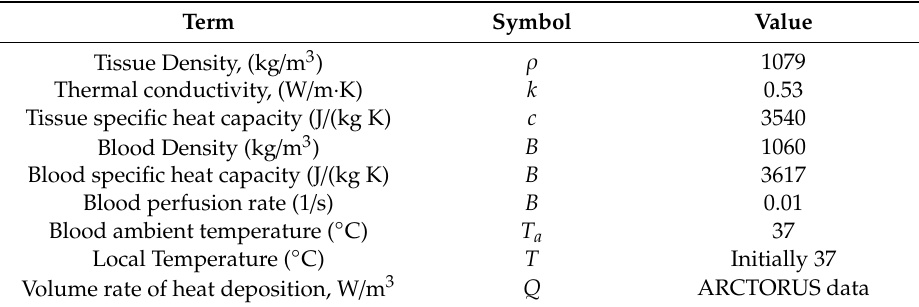
Table 2. Values used for the Bioheat Transfer